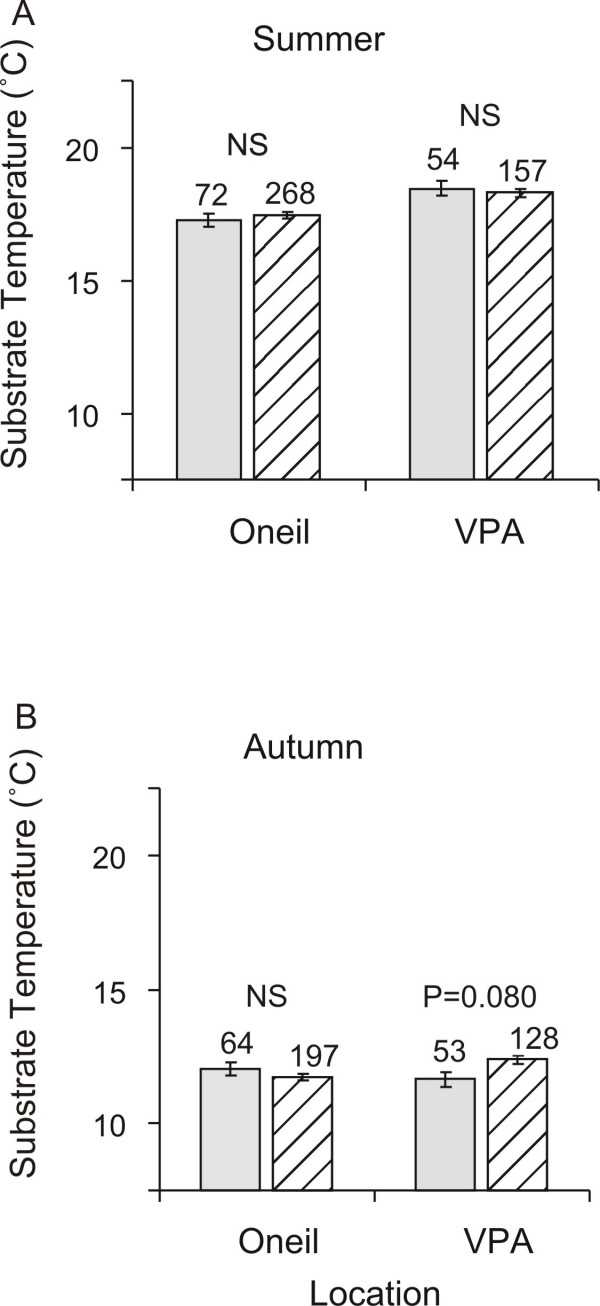
Substrate Temperature by Location and Season. Least-Square Means for Substrate Temperature (°C) where colour morphs were found by location in the (a) autumn and (b) summer. Solid bars are black morphs, and striped bars are striped morphs. Error bars represent ± 1 SE. Numbers above each bar indicate sample size. NS indicates no significant difference between morphs (p > 0.1).